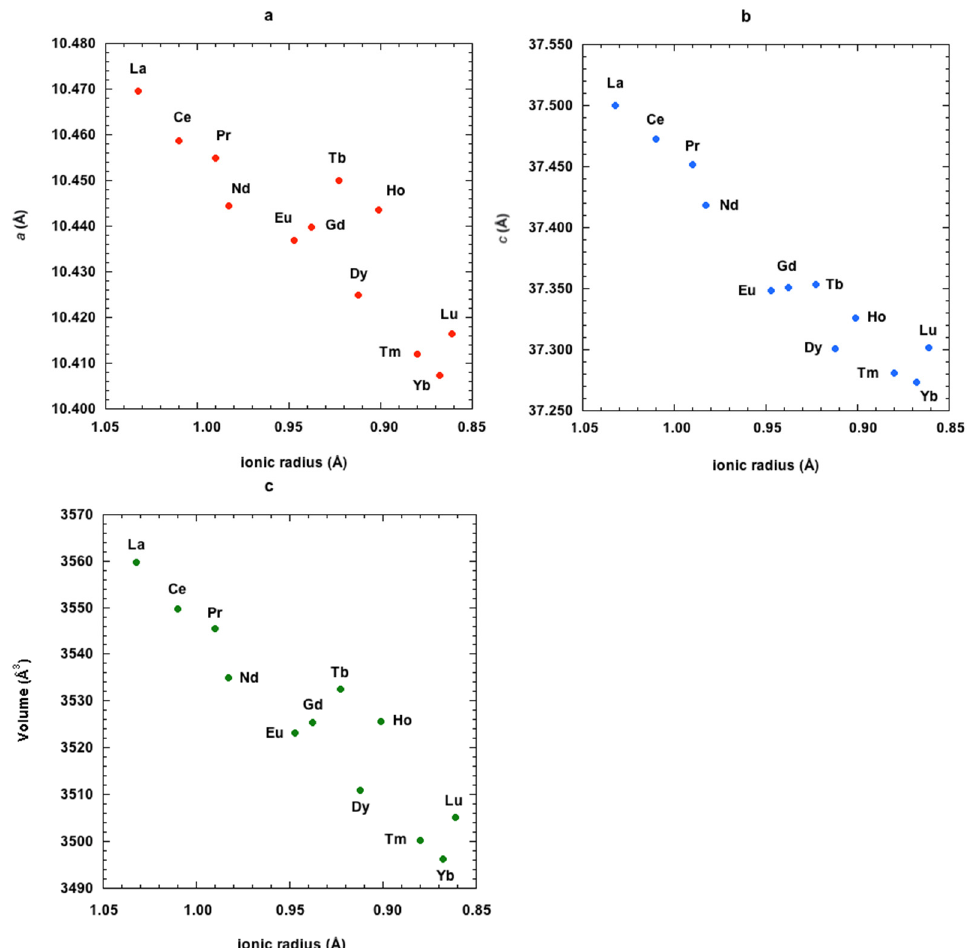
Figure 2. Unit cell parameters of RE β –TCP as a function of RE ionic radius (for 6-folded polyhedra). ( a ) a parameter (Å); ( b ) c parameter (Å); ( c ) Volume (Å 3 ). Data from [6], except Ce [30], Lu [31], Tb and Ho